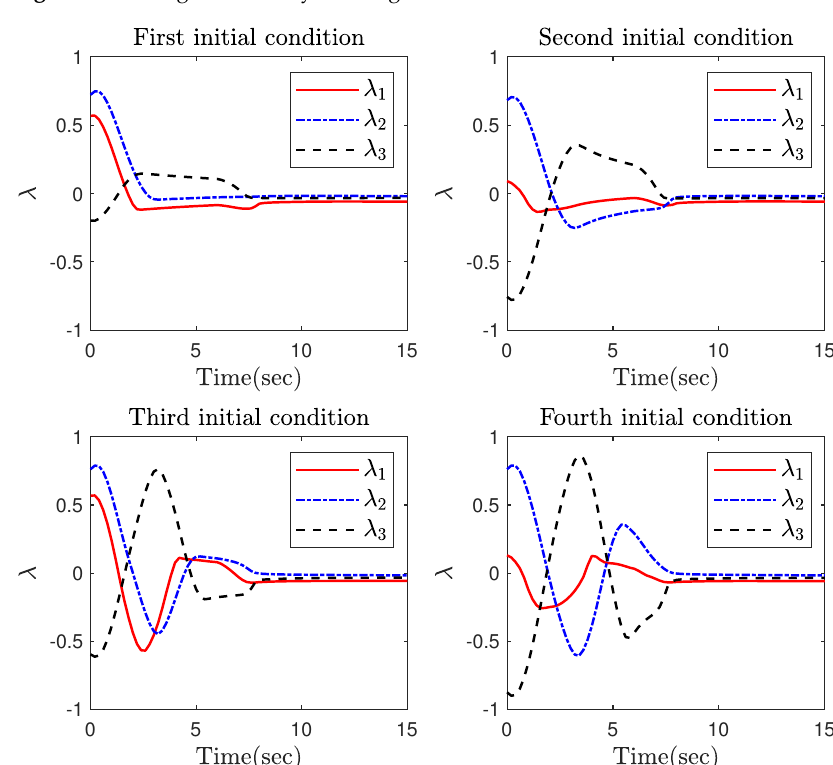
Figure 6. The time-varying gain λ in Part